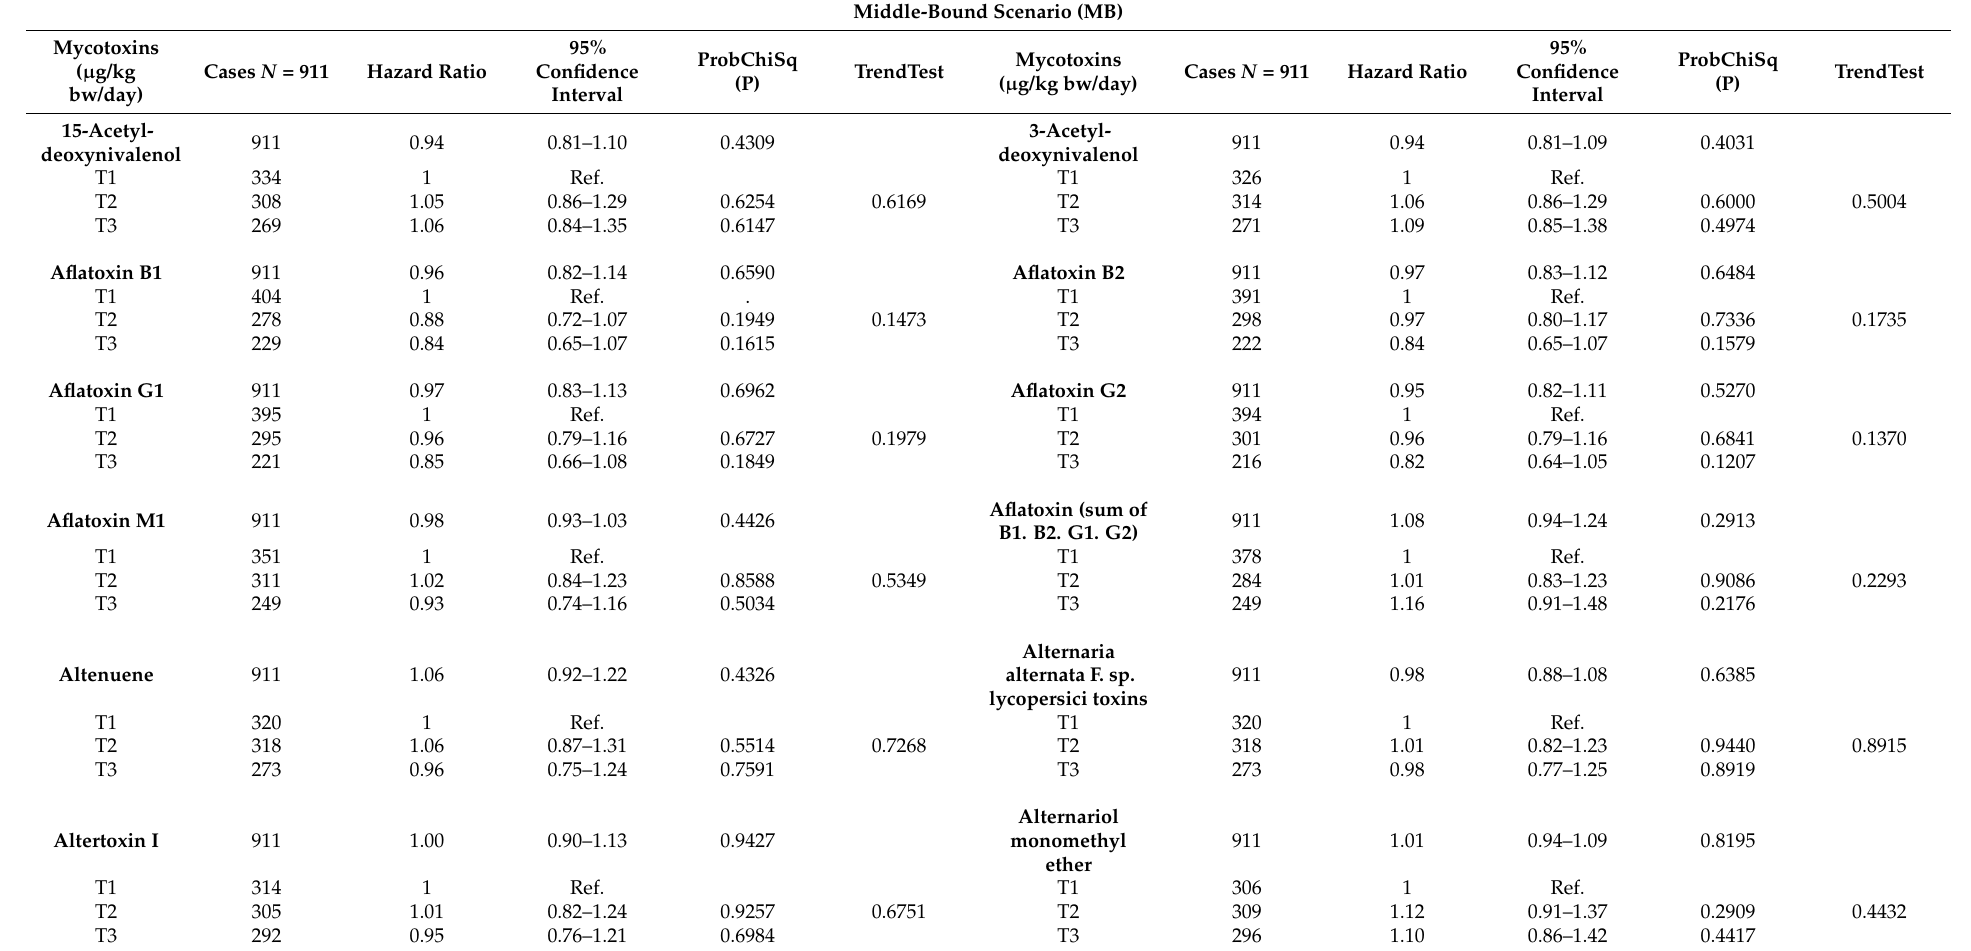
Table 3. Hazard ratios (HRs) and their 95% confidence intervals (CIs) for the associations between mycotoxin exposures ( µ g/body weight/day) and renal cell carcinoma risk using a fully adjusted model * for the continuous exposure and tertiles ( n = 450,112; cases = 911 and non-cases = 449,201). The HRs for the continuous variables have been computed on the log 2 scale: risk for a doubling of the exposure. Tests for trend were computed using the tertile score (1–3 as a continuous variable) specific to each